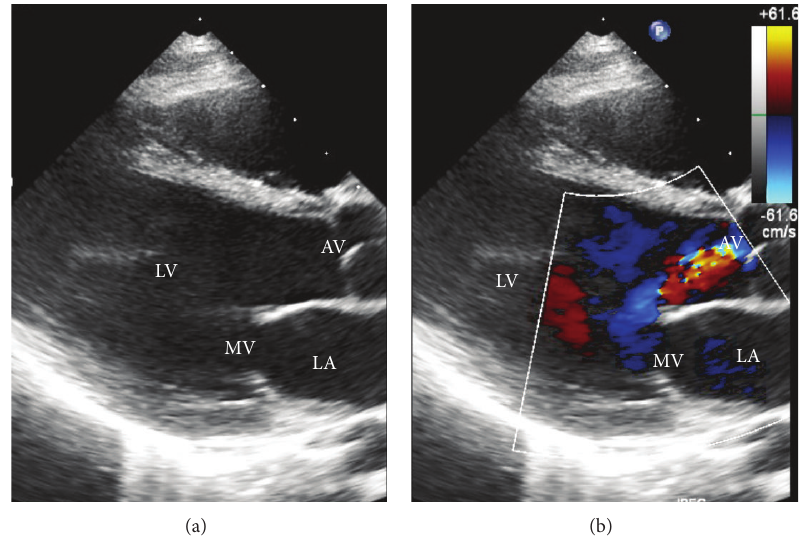
Figure 3: Parasternal long axis view showing (a) orientation of the aortic valve (AV), left ventricle (LV), and left atrium (LA) and (b) aortic valve (AV) and mitral valve (MV) regurgitations demonstrated by blue jets of retrograde flow on